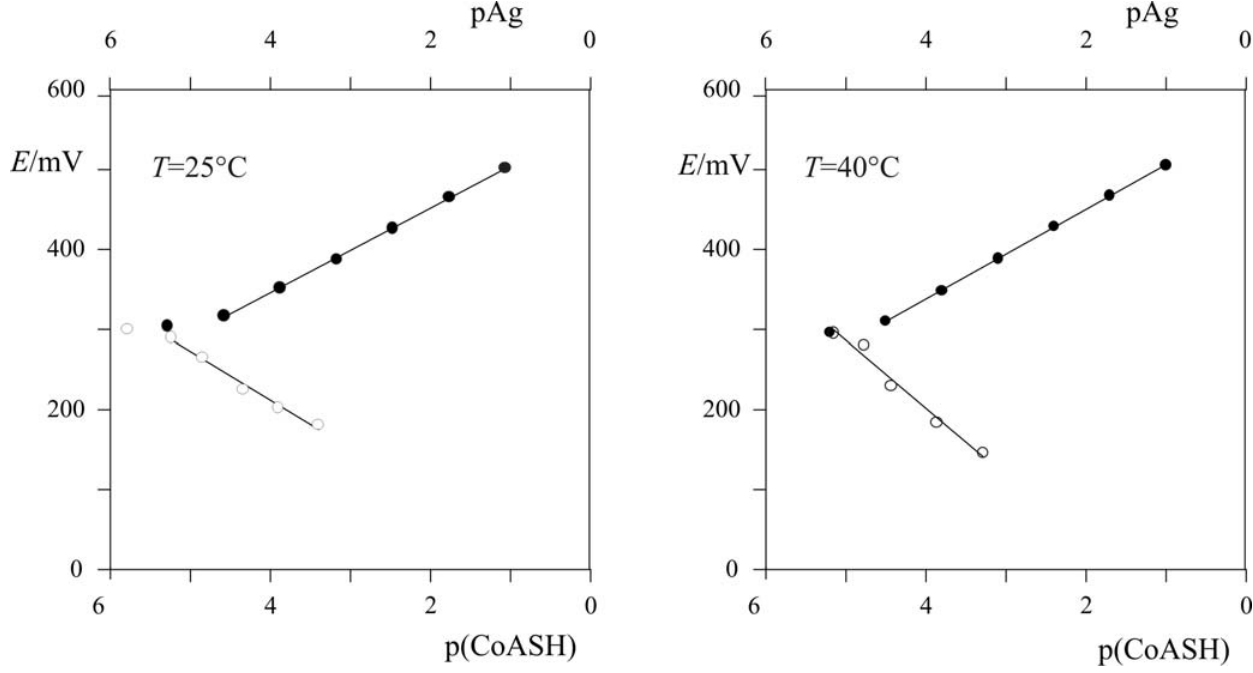
Figure 4. CoASH determination using classic potentiometric with constant mixing at (a) 25 °C and (b) 40 °C; (cid:122) - Ag, (cid:123) -